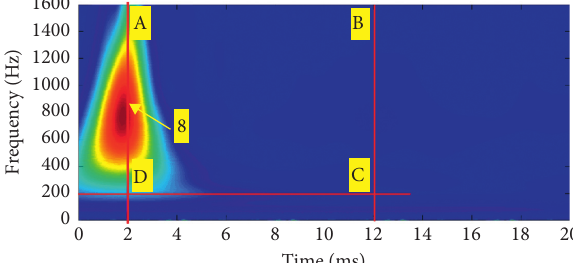
Figure 12: Wavelet scalogram of the velocity response signal.